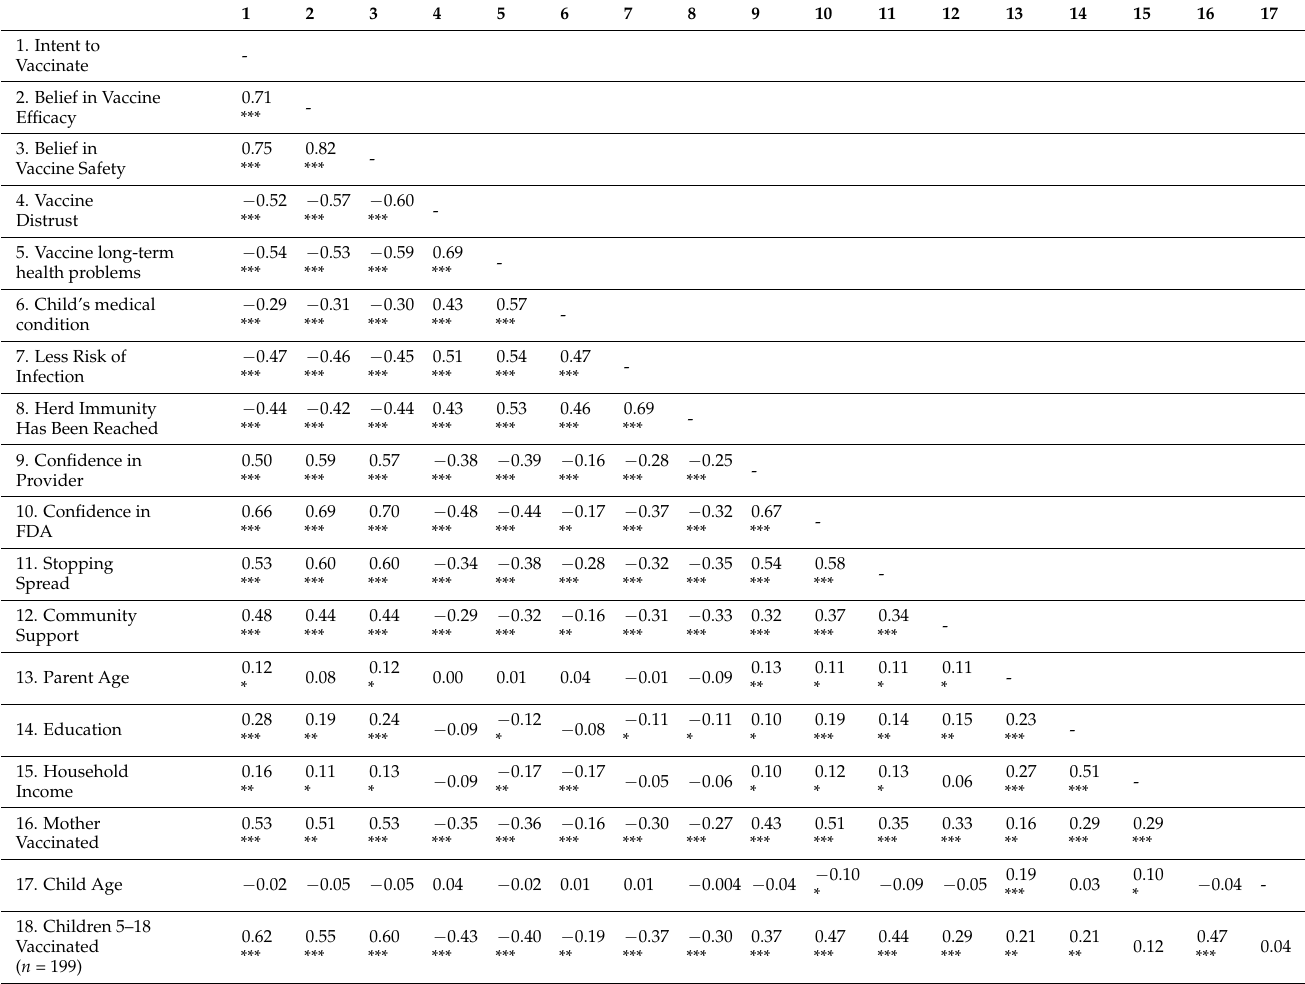
Table 3. Bivariate correlations between intent to vaccinate, parental COVID-19 pediatric vaccination beliefs, community support, and demographic